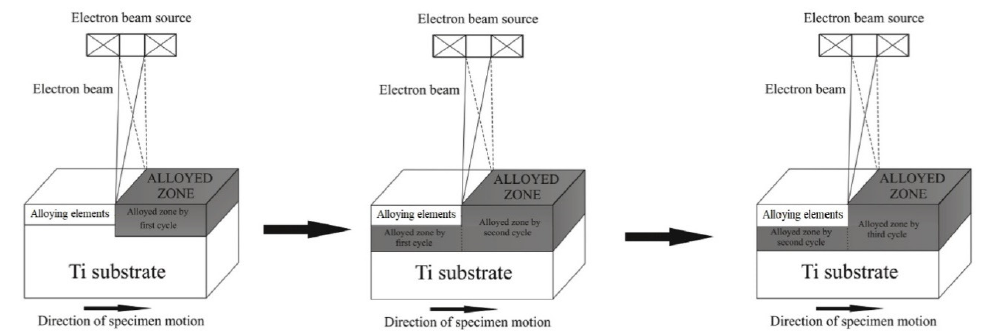
Figure 12. Scheme of cyclic electron-beam surface alloying of Ti substrate with Al/Nb bilayer coating [66]. (Reproduced with permission from ref. [66]. Copyright (2018), Elsevier).